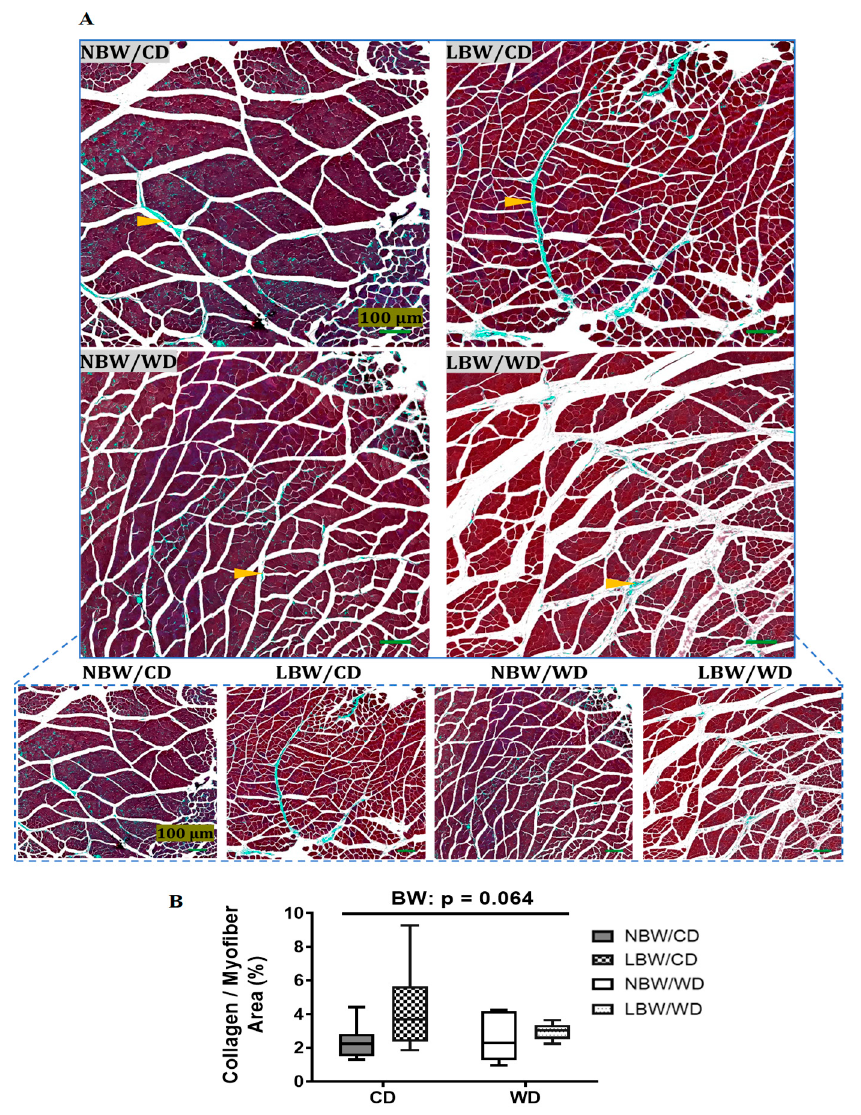
Figure 4. Muscle fibrosis in guinea pig offspring. Sections were stained with Masson’s trichrome to identify collagen deposition (orange arrowheads) at postnatal day 145 in guinea pig offspring fed a postnatal CD or WD. ( A ) Representative fields at high and low magnification and ( B ) percentage of collagen deposition/myofiber area are displayed. Data are presented as min. to max. box and whisker plots for 5–9 animals/experimental group. p value indicates the main effect of birth (BW) way using a regular two-way.